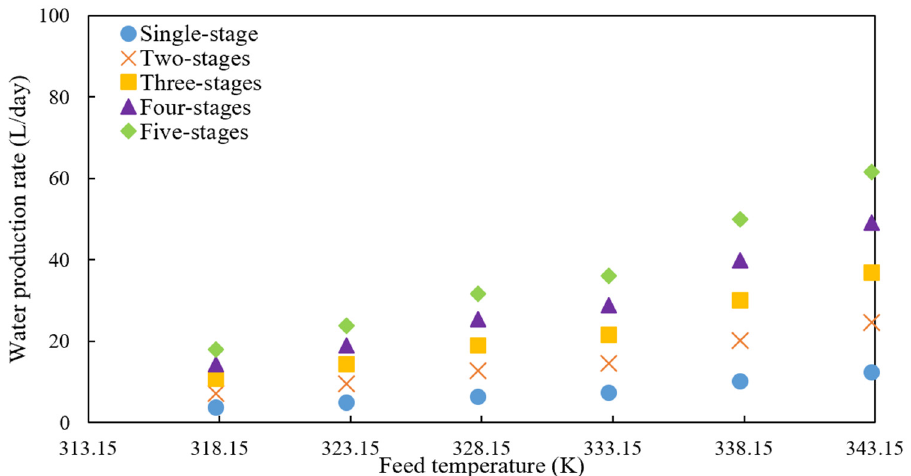
Figure 9. The daily water production versus the number of stages with experimental results.